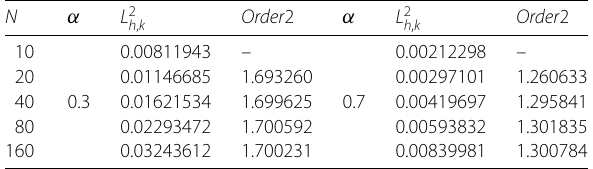
Table 3 The time-convergent orders and errors of PASE-I scheme solution ( M = 1001)